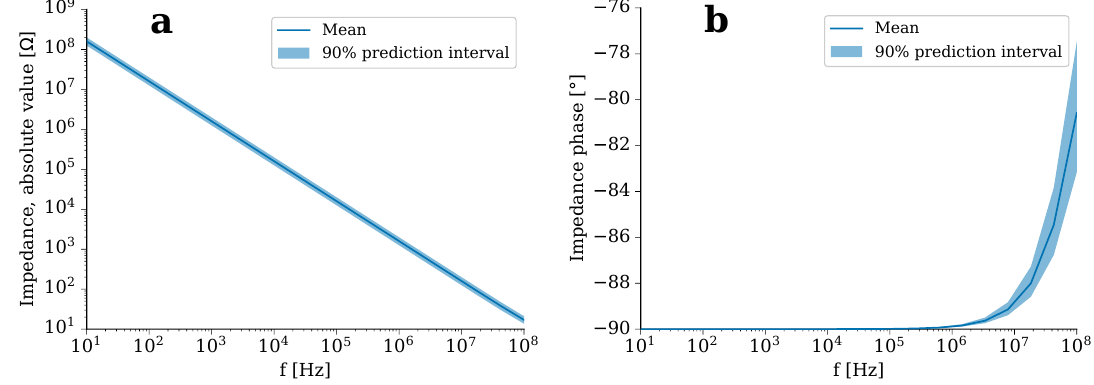
Figure 3. Uncertainty quantification (UQ) result for ( a ) the absolute value and ( b ) the phase of the impedance of the equivalent circuit (Equation (1)). The mean value is shown together with 90% prediction interval for a broad frequency